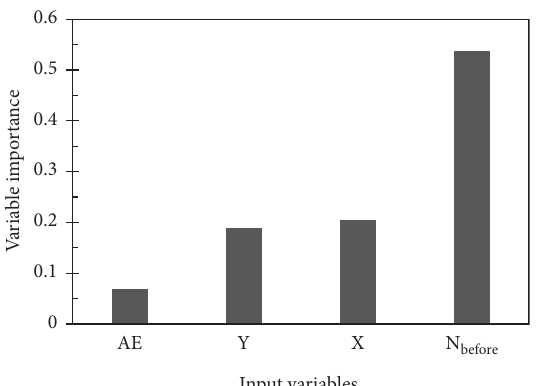
Figure 11: Variable importance for the ANN model versus input variables such as X-coordinate, Y-coordinate, applied energy (AE), and averaged SPT N value before dynamic compaction (N before ).